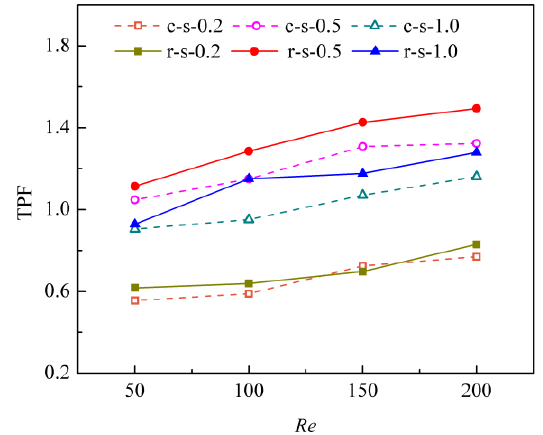
Figure 13. Variation of TPF vs. pin-fin height.